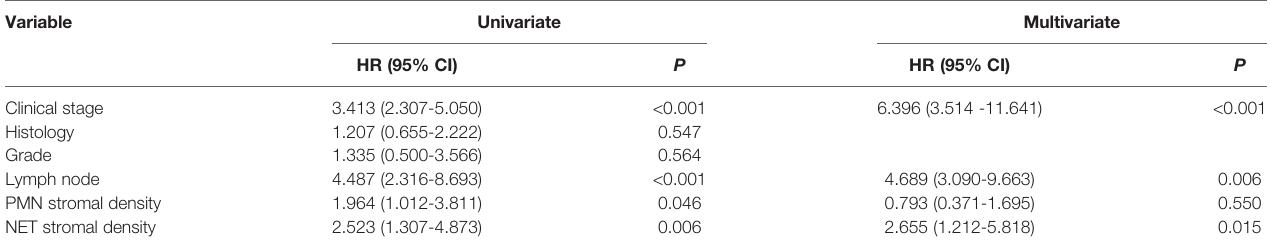
TABLE 6 | Univariate and multivariate analyses of the association of different variables with RFS. Variable